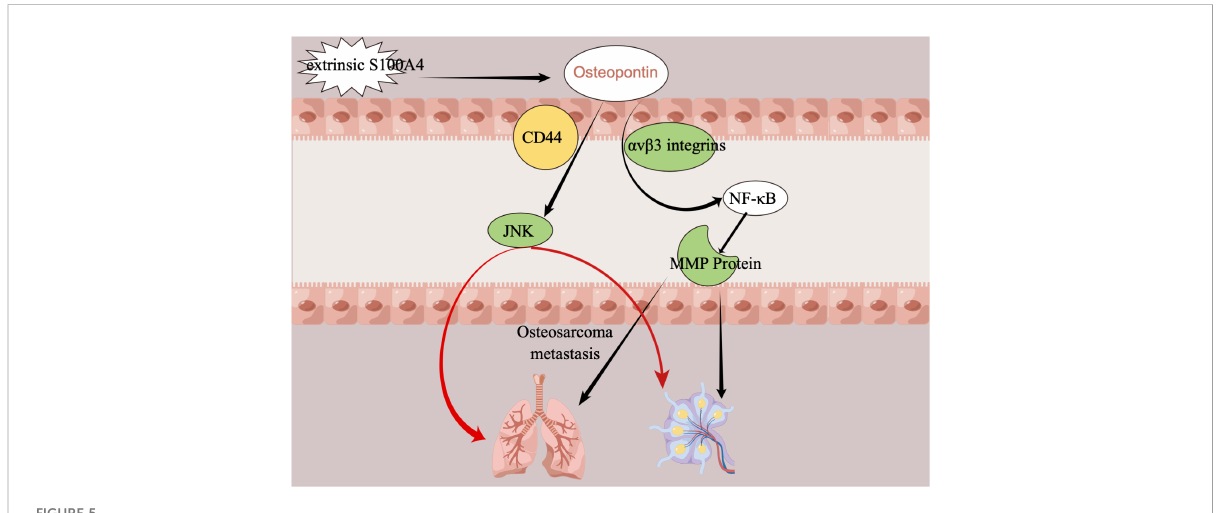
FIGURE 5 The mechanism of action of OPN in the metastatic process of osteosarcoma. CD44, extracellular matrix receptor III; MMP, matrix metalloproteinase; NF- k B, nuclear factor- k B; JNK, c-JUN N-terminal